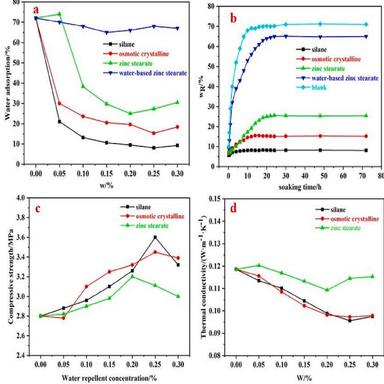
Effects of water-repellents on (a) water absorption, (b) water absorption with soaking time, (c) compressive strength, and (d) thermal conductivity of AAC.